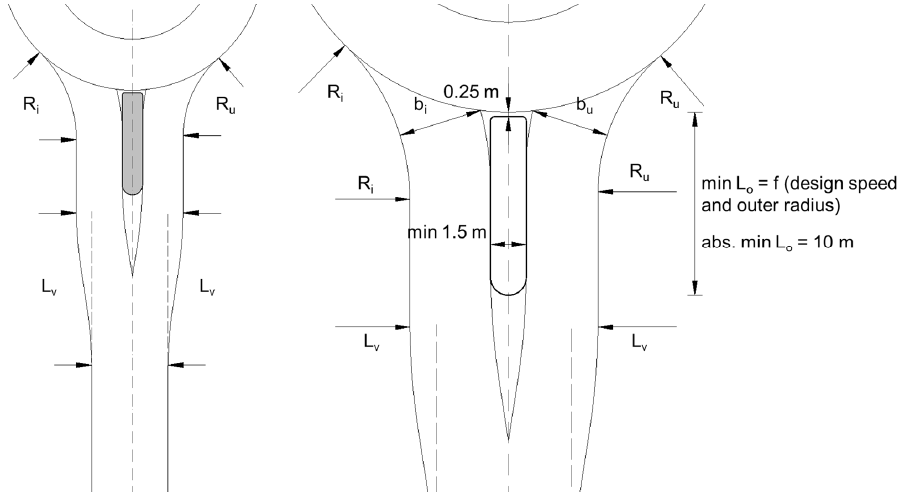
Figure 17. Splitter islands for a low level of traffic-flow channeling [10].